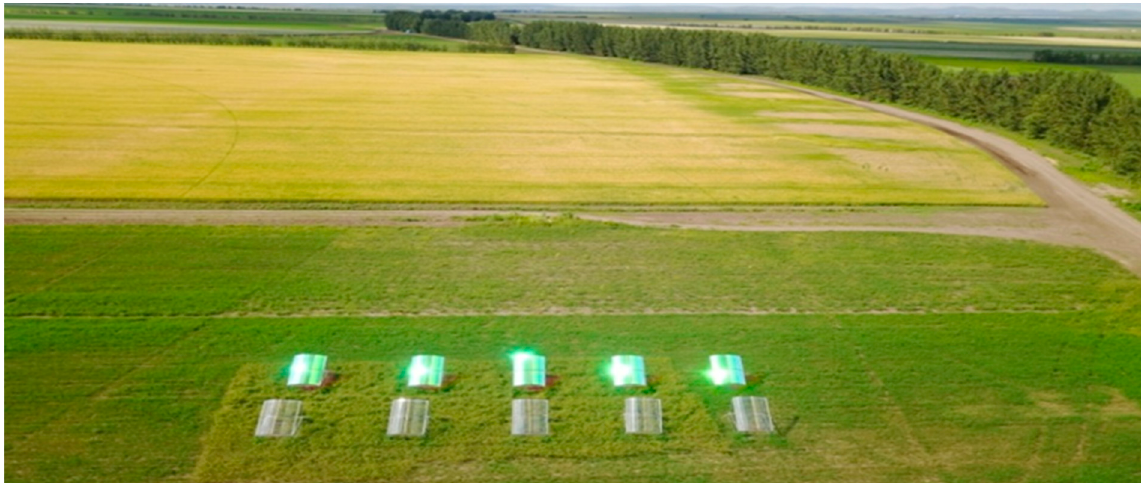
Figure 9. The photo of forage planting experiments in the Hulunbuir Prairie in Hailar, in Inner Mongolia province.